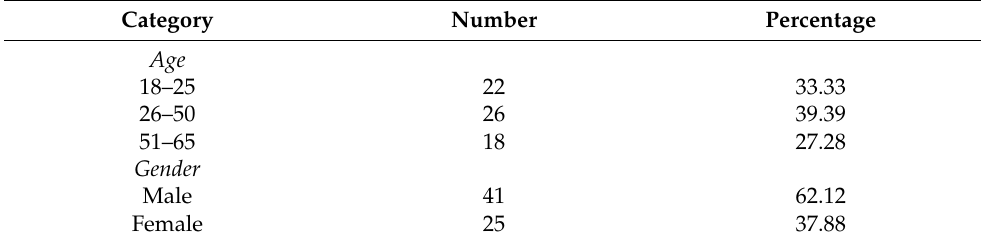
Table 1. Features of